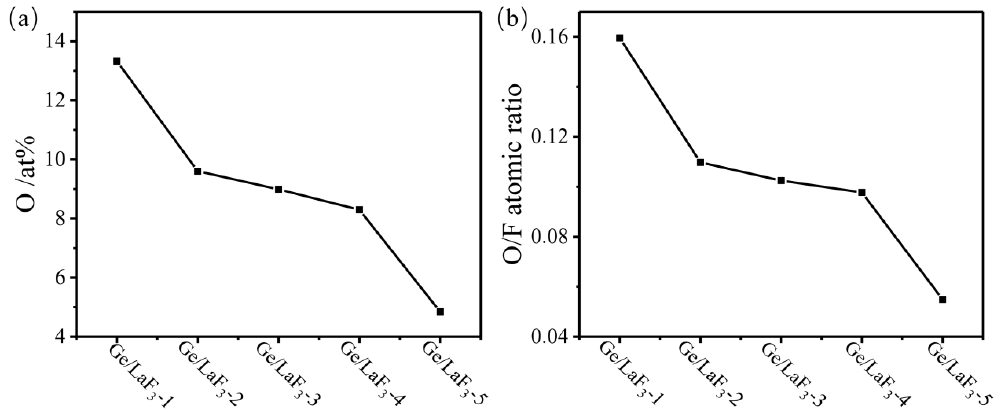
Figure 3. Chemical compositions of LaF 3 thin films, ( a ) O atomic percentage, ( b ) O/F atomic ratio.